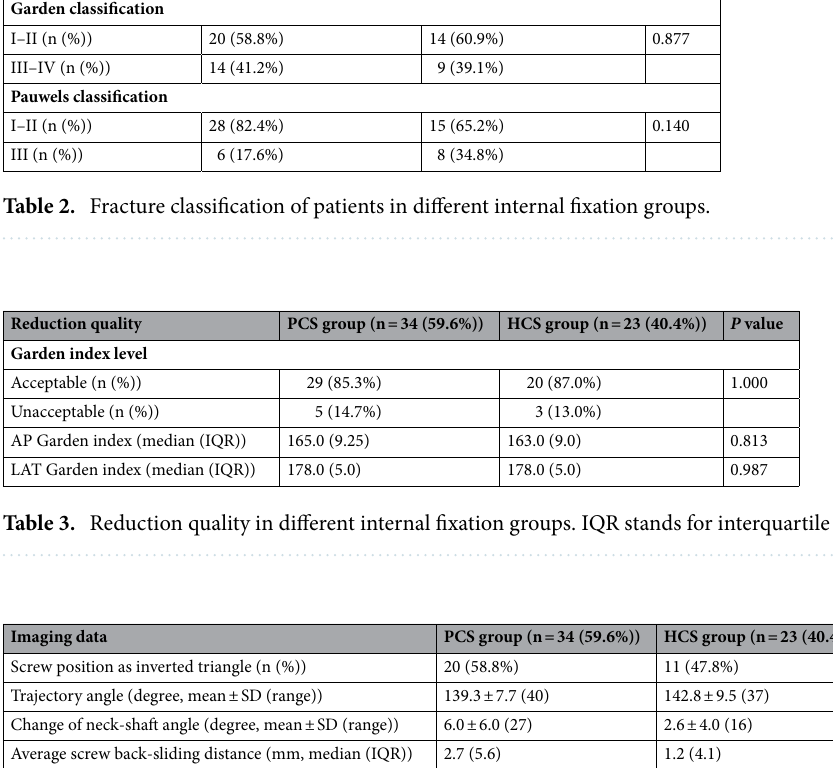
Table 4. Postoperative imaging changes in different internal fixation groups. SD and IQR stand for standard deviation and interquartile range respectively.